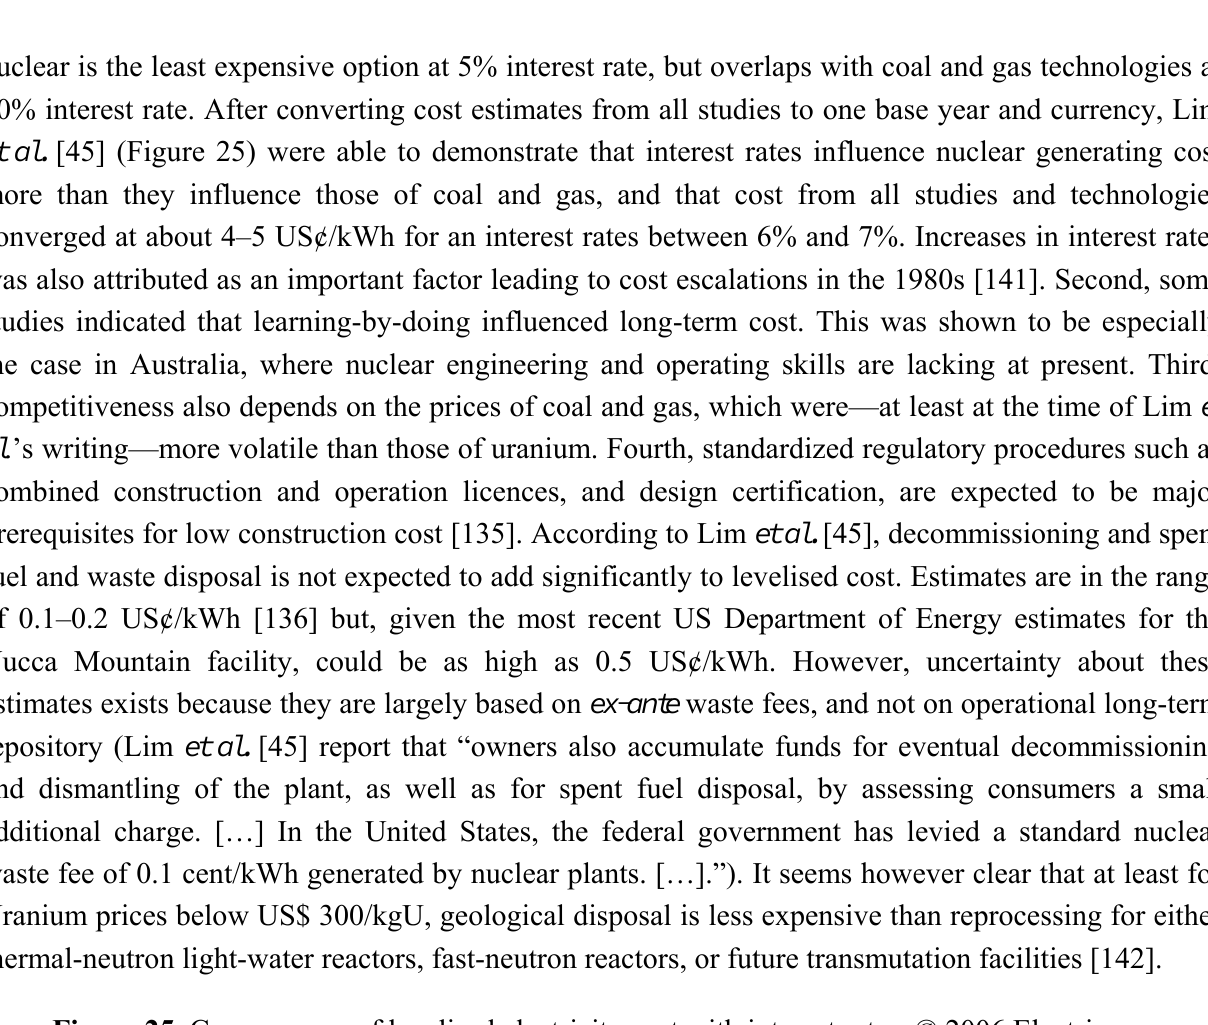
Figure 25. Convergence of levelised electricity cost with interest rates. © 2006 Electric Power Research Institute, reproduced from [45] with